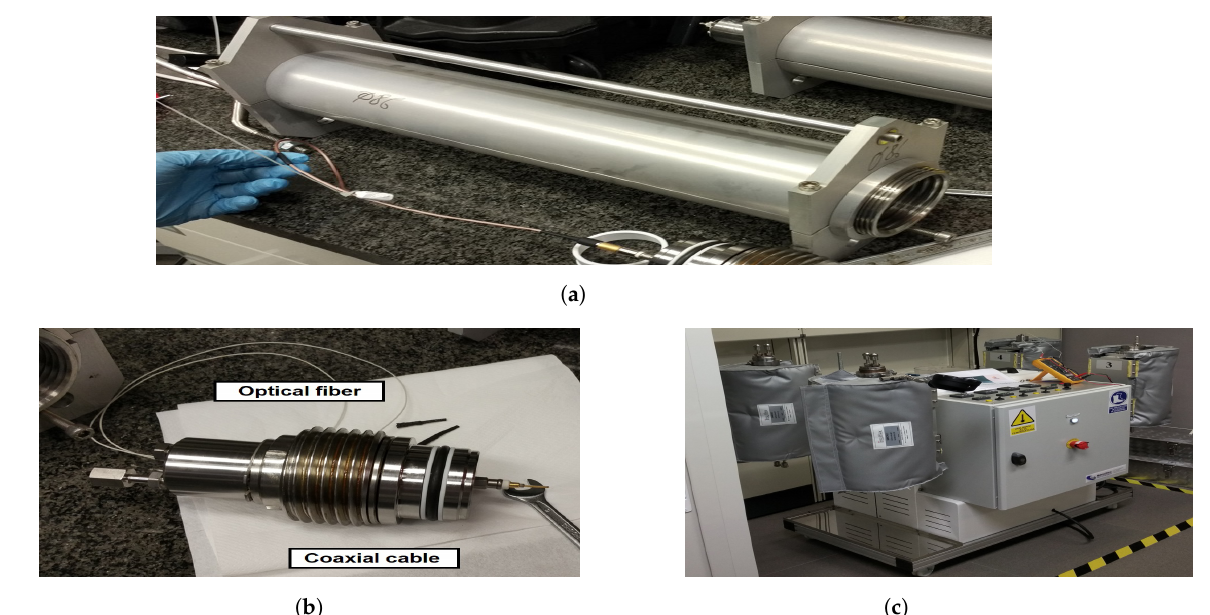
Figure 15. High-pressure and high-temperature measurement setup: high-pressure bottle ( a ), feed- through ( b ), and bottle holder and heater ( c ).